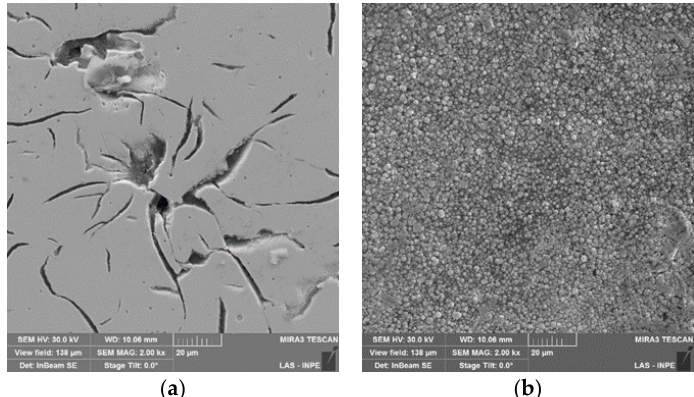
Figure 6. SEM–FEG micrograph on the surface exposed to palm biodiesel by 1320 h. ( a ) Gray cast iron and ( b ) NbC coating.